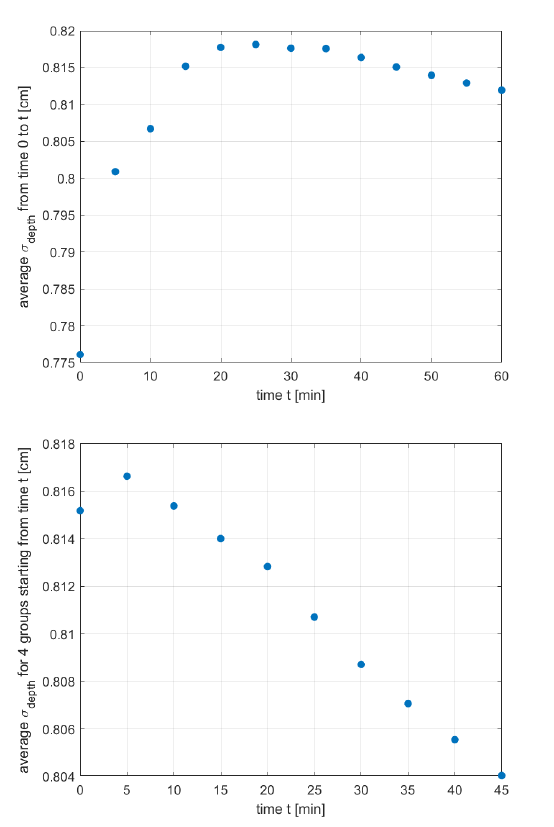
Figure 6. Average σ depth obtained averaging acquired depths on consecutive time instants. (a) Standard deviation computed considering measurements acquired from time 0 to t . (b) Standard deviation computed considering measurements from a 16-minute fixed-horizon starting from each of the considered time t